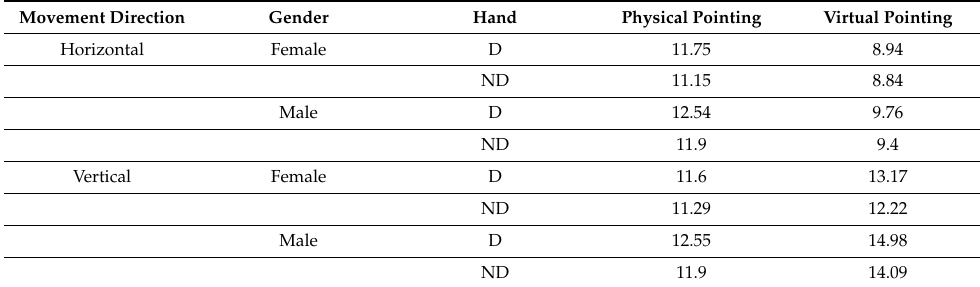
Table 5. Throughput (bit/s) for the pointing tasks. Movement Direction